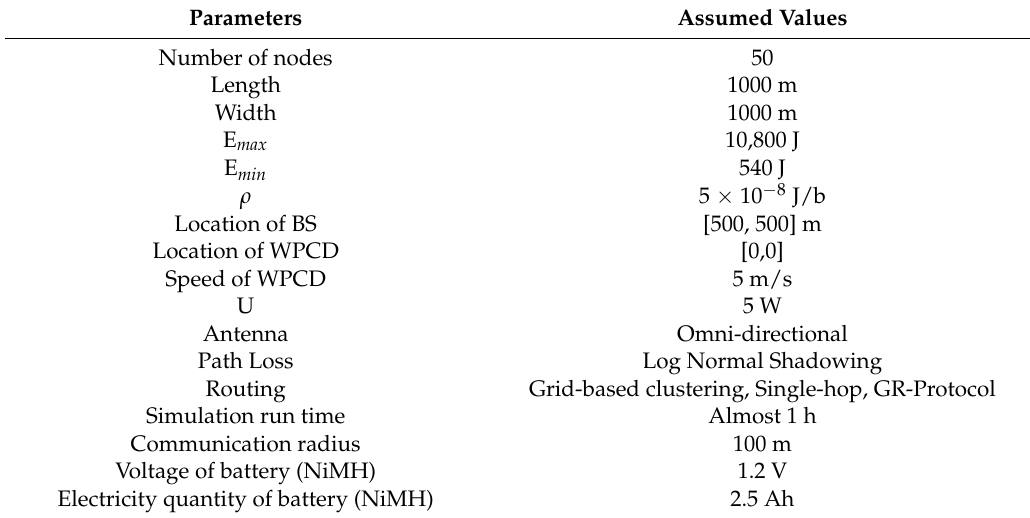
Table 2. Simulation